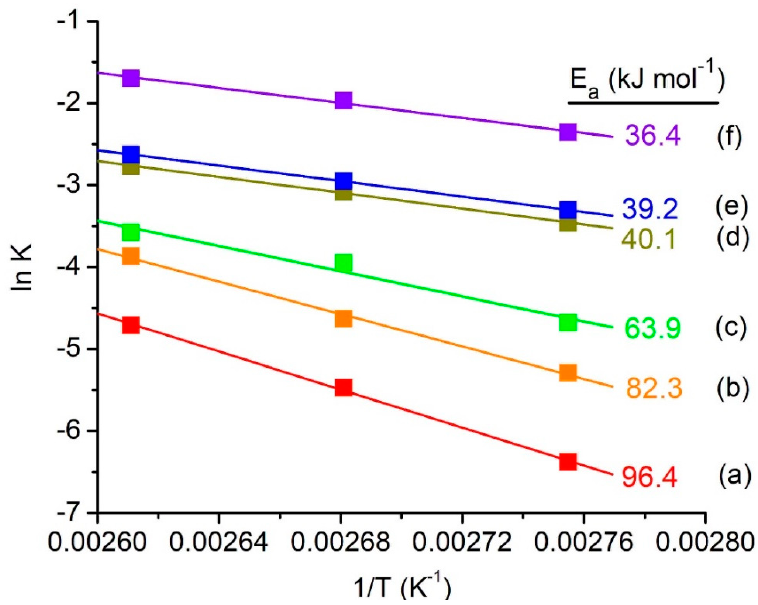
Figure 6. The Arrhenius linear plots and activation energies (E a ) of acylation of 2-methylfuran catalyzed by ( a ) pristine SAPO-5, ( b ) CuCl x /SAPO-5, ( c ) CoCl x /SAPO-5, ( d ) SnCl x /SAPO-5, ( e ) FeCl x /SAPO-5 and ( f ) ZnCl x /SAPO-5. Reaction conditions: Catalyst = 0.20 g, 2-methylfuran = 4.7 mmol, acetic anhydride = 14.1 mmol, reaction temperature: 90, 100 and 110 °C, time = 0–20 min, solvent-free.